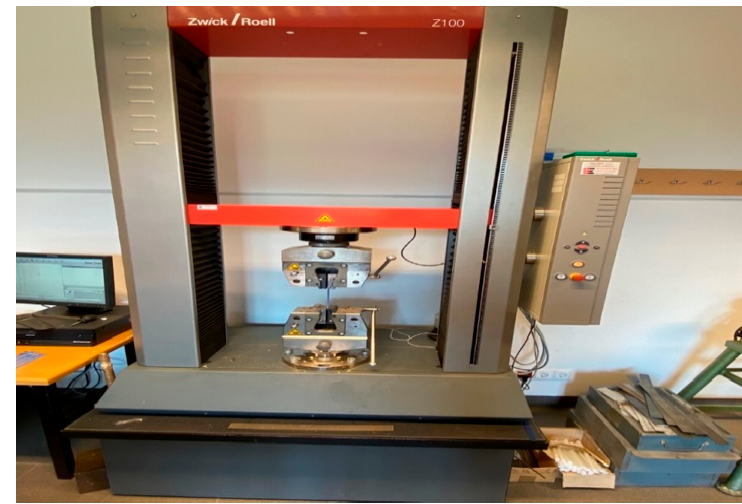
Figure 3. Testing tensile specimens, Testometric.